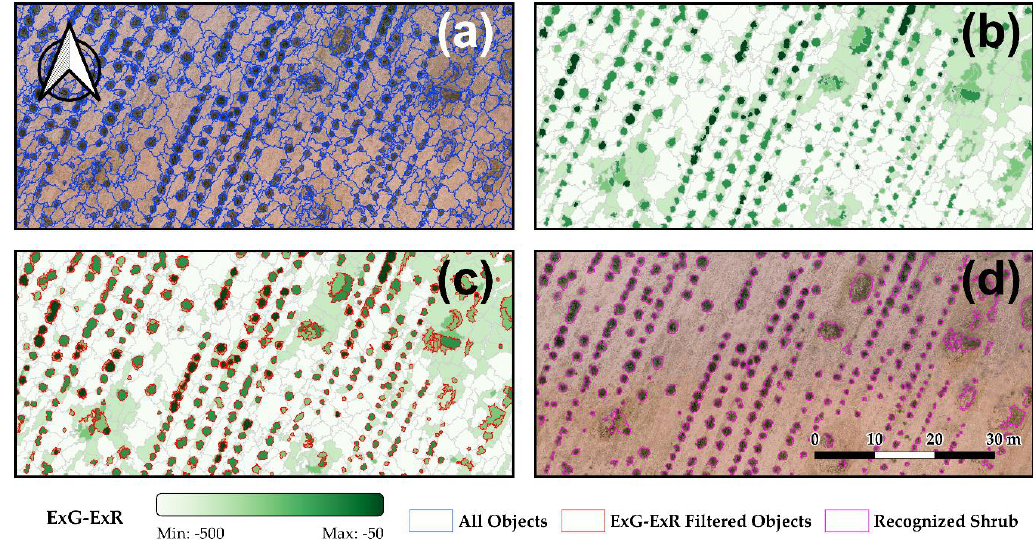
Figure 3. Object-oriented filter (OOF) based shrub identification approach: ( a ) multiresolution segmentation result; ( b ) ExG-ExR features of objects; ( c ) threshold classification result; ( d ) identified Shrub Area.